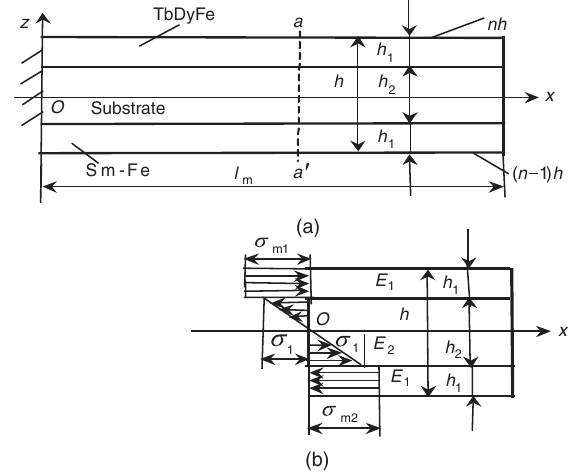
Figure 5 Stress analysis of a GMF and its equivalent